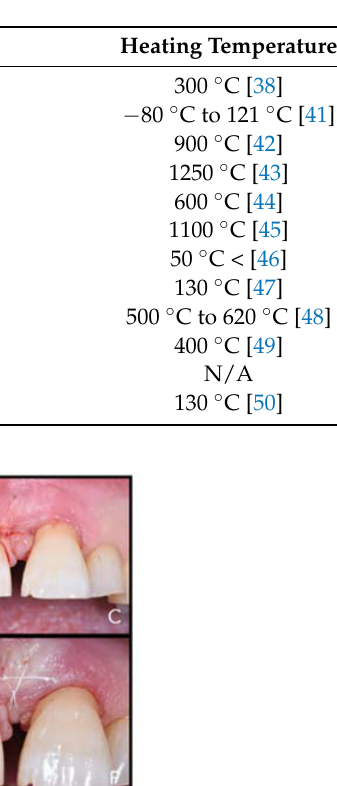
Table 1. Commercialized bone substitutes and heating temperature according to their production process and the manufacturing protocol.